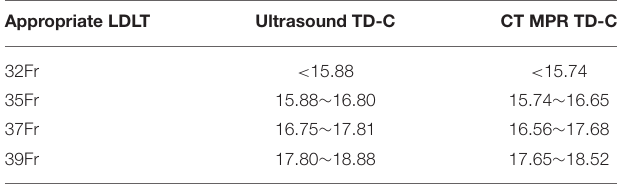
TABLE 2 | The range of appropriate